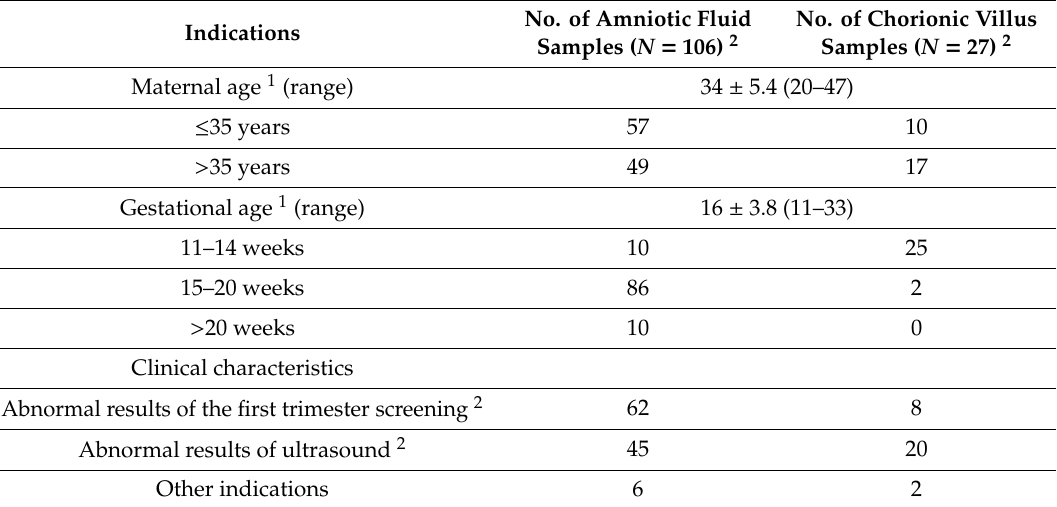
Table 2. Clinical data and indications for invasive prenatal